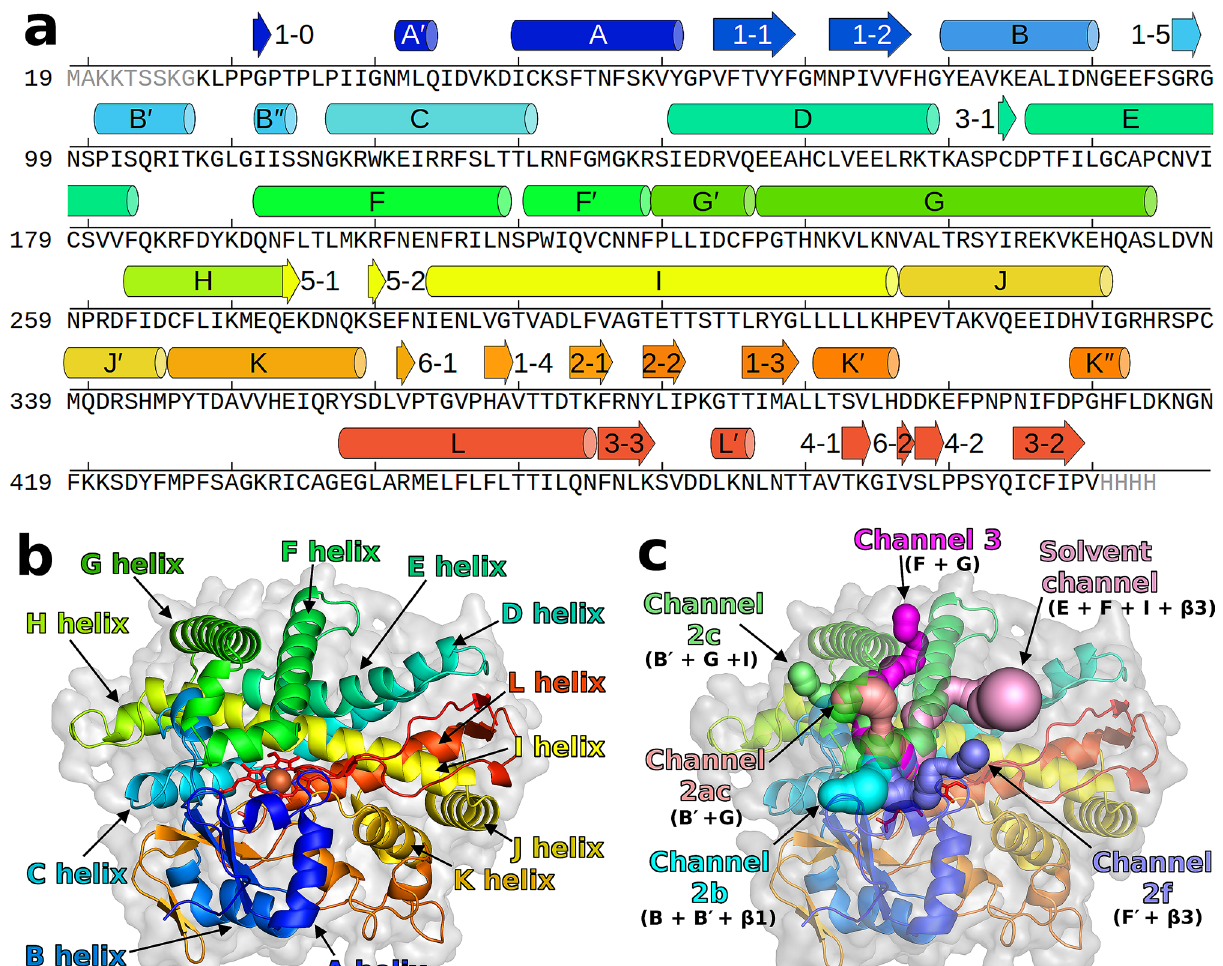
respect to the annotated SSEs. Some SSEs (B ″ , β1-0, β5-1, β5-2, β6-1, β6-2) are not really present in 2nnj but they are shown to illustrate their location in other CYPs. The table of residue ranges of the SSEs is included in Supplementary Table S1. These figures were created using PyMOL 2.3 19 and GIMP 2.10.18 (https:// www. gimp.